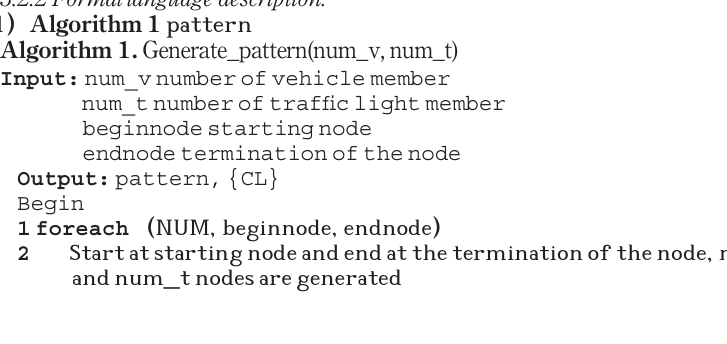
Algorithm 1. Generate_pattern(num_v,